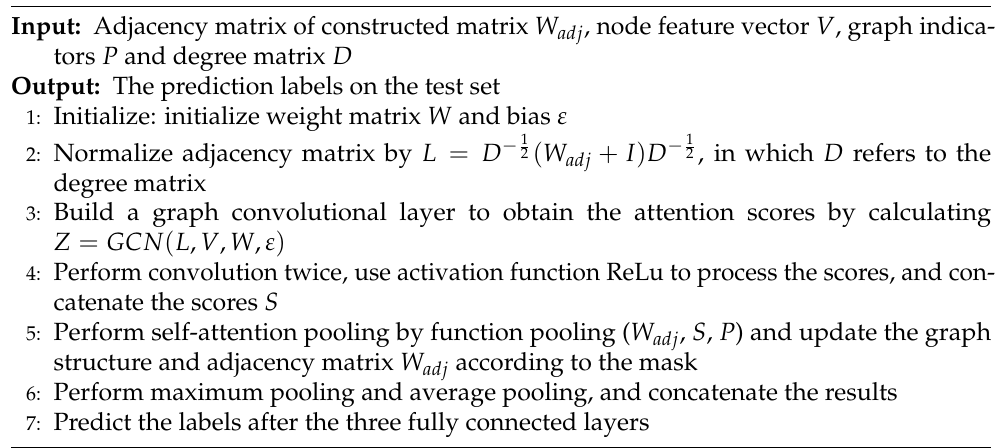
Algorithm 2 Graph classification based on improved self-attention